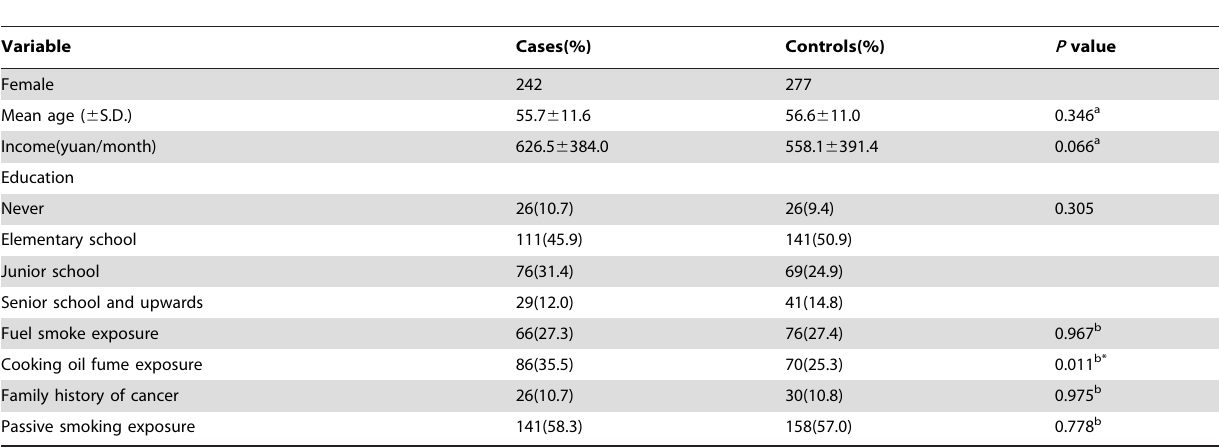
Table 3. Basic demographic data and environmental risk factor in lung adenocarcinoma cases and